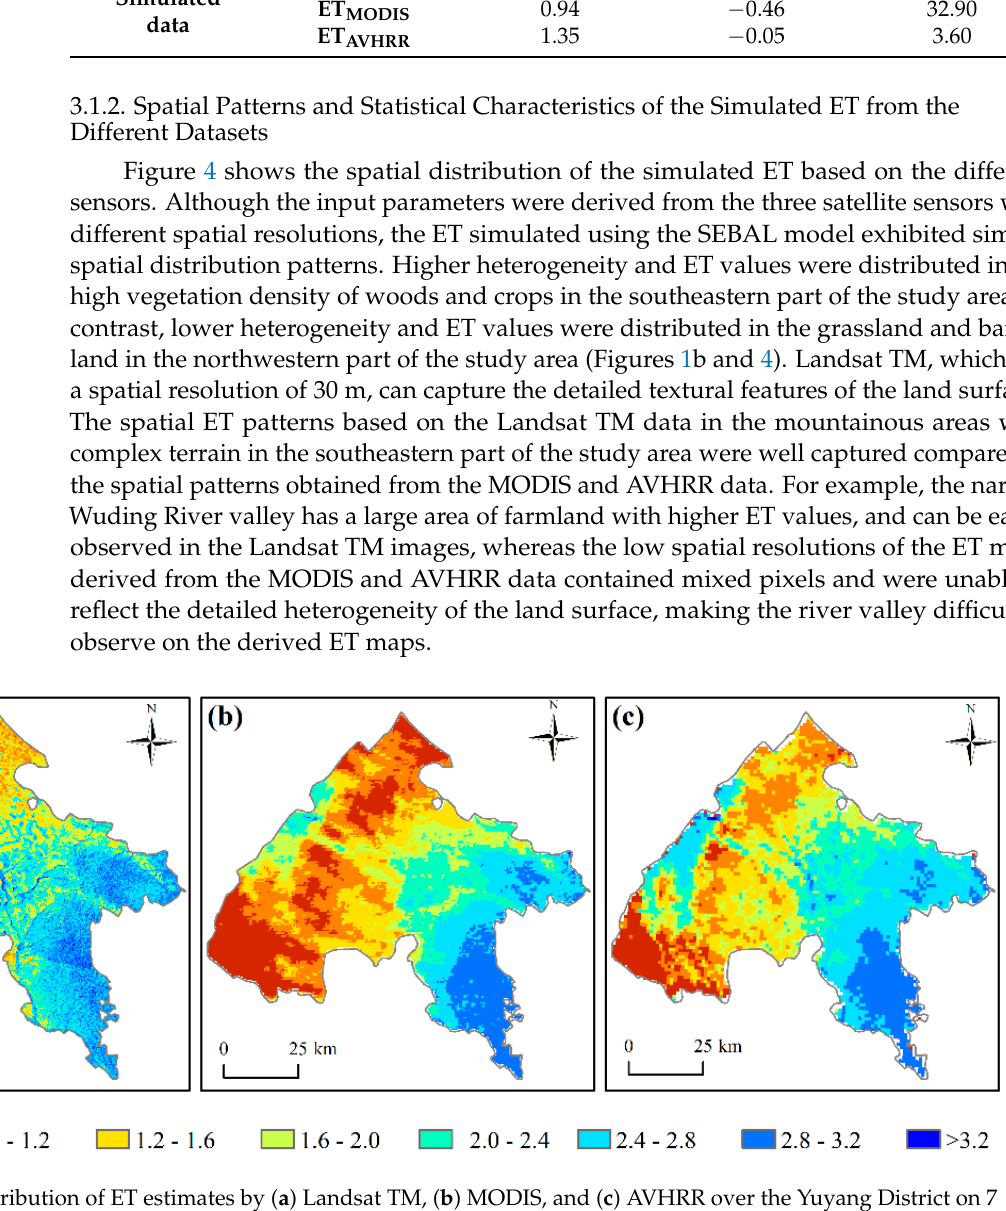
Figure 5. Frequency distribution and statistics of the ET estimates from ( a ) Landsat TM, ( b ) MODIS and ( c ) AVHRR.